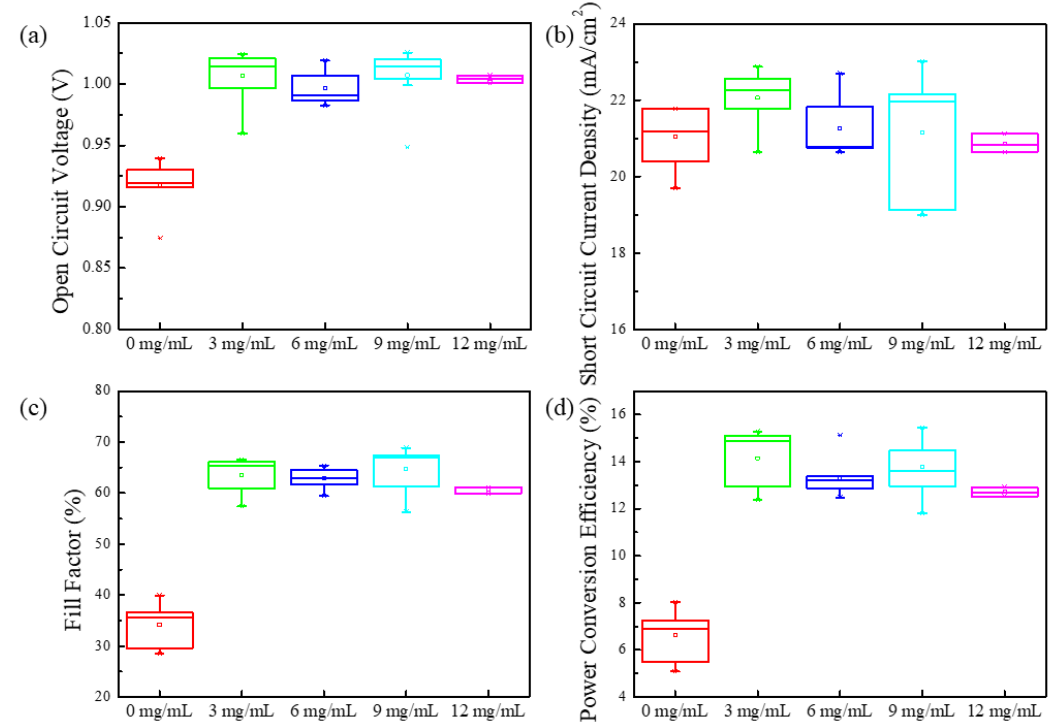
Figure 3. Photovoltaic parameters of PSCs evaporated with gold electrode.